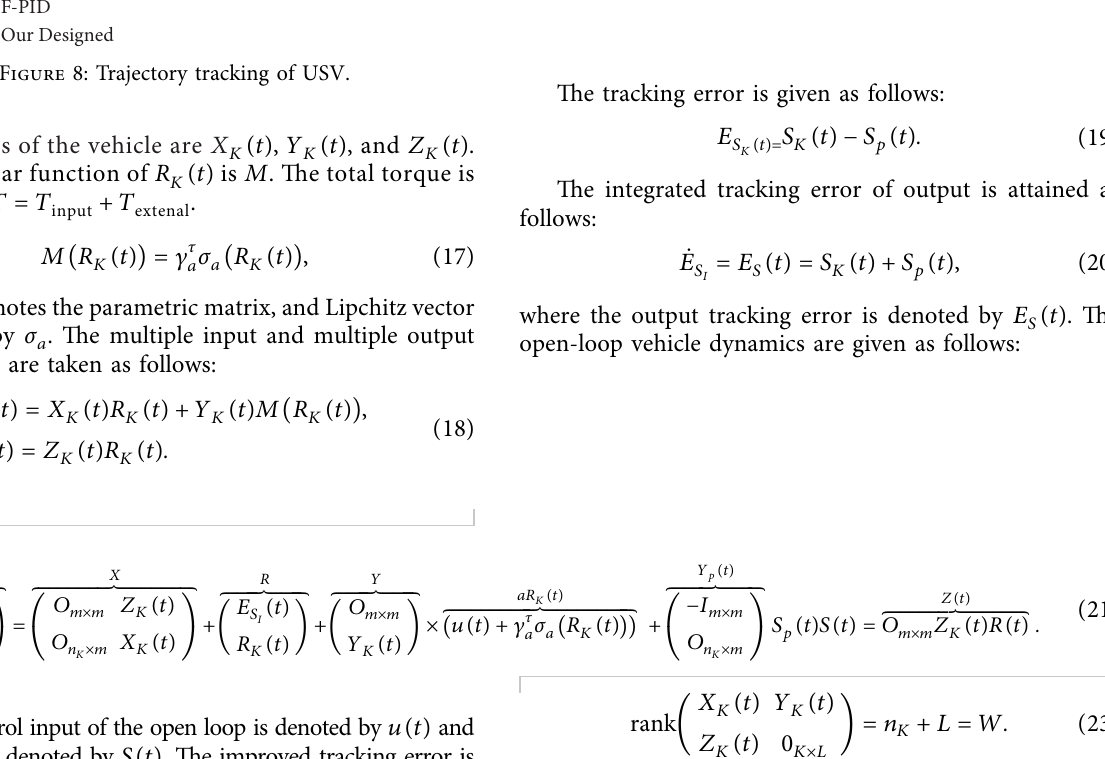
Figure 9: Torque curves with respect to